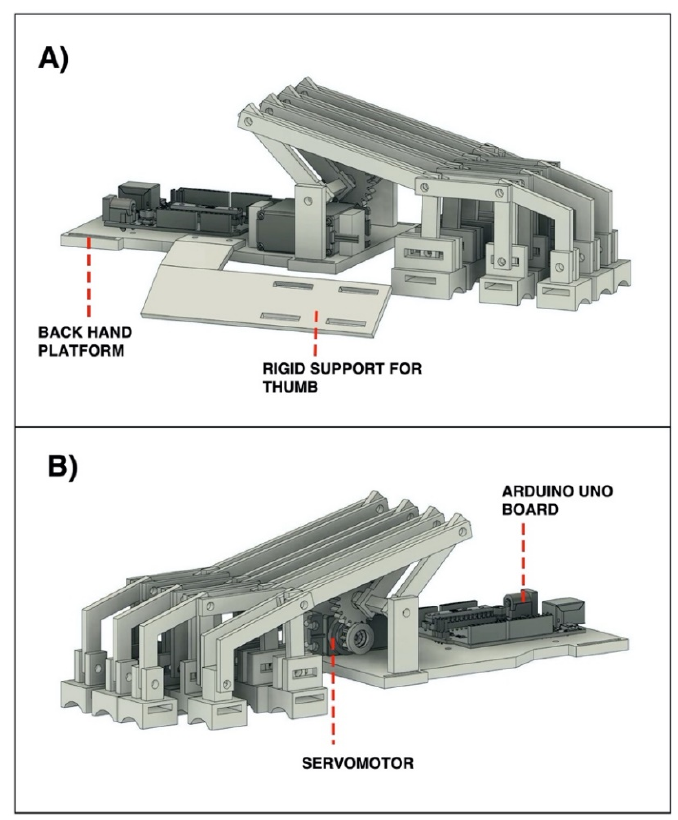
Figure 1. The 3D renderings of the hand exoskeleton: ( A ) view from the thumb side; ( B ) view from the little finger side.